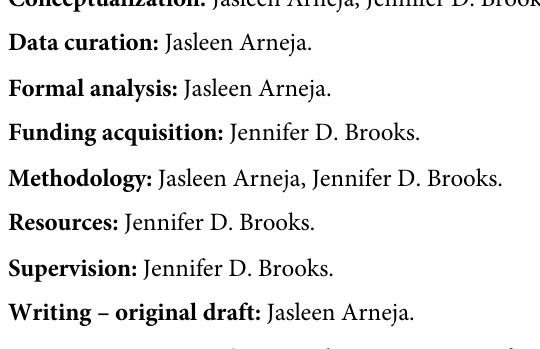
S2 Table. Unadjusted estimates of the relationship between the number of chronic condi- tions at breast cancer diagnosis, and the study outcomes: (i) quality of life, and (ii) emo- tional health, among breast cancer survivors in the Transitions